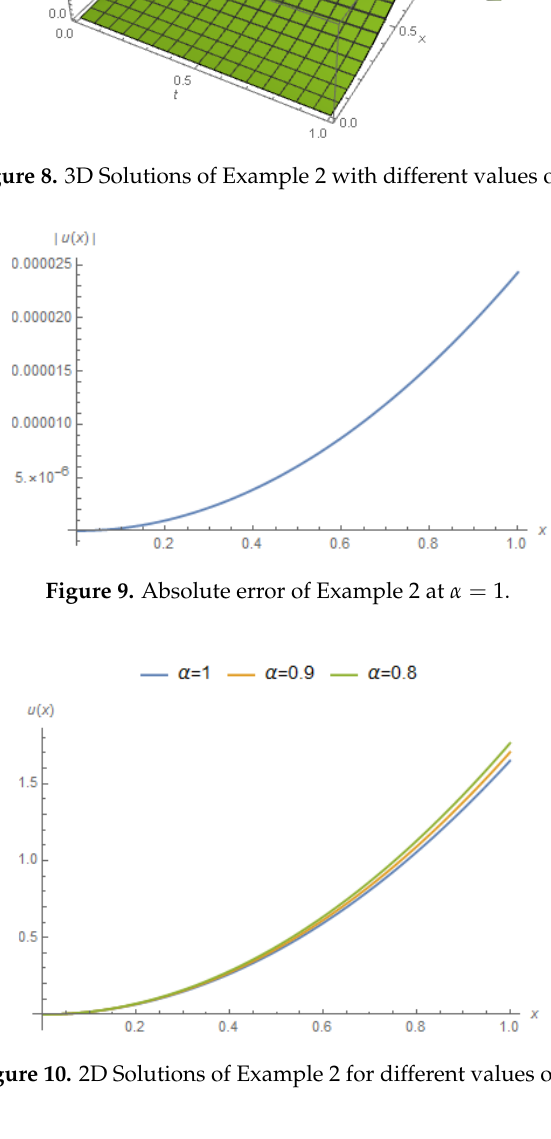
Figure 2:3D approximate Solution of example2 with (cid:11) = 1